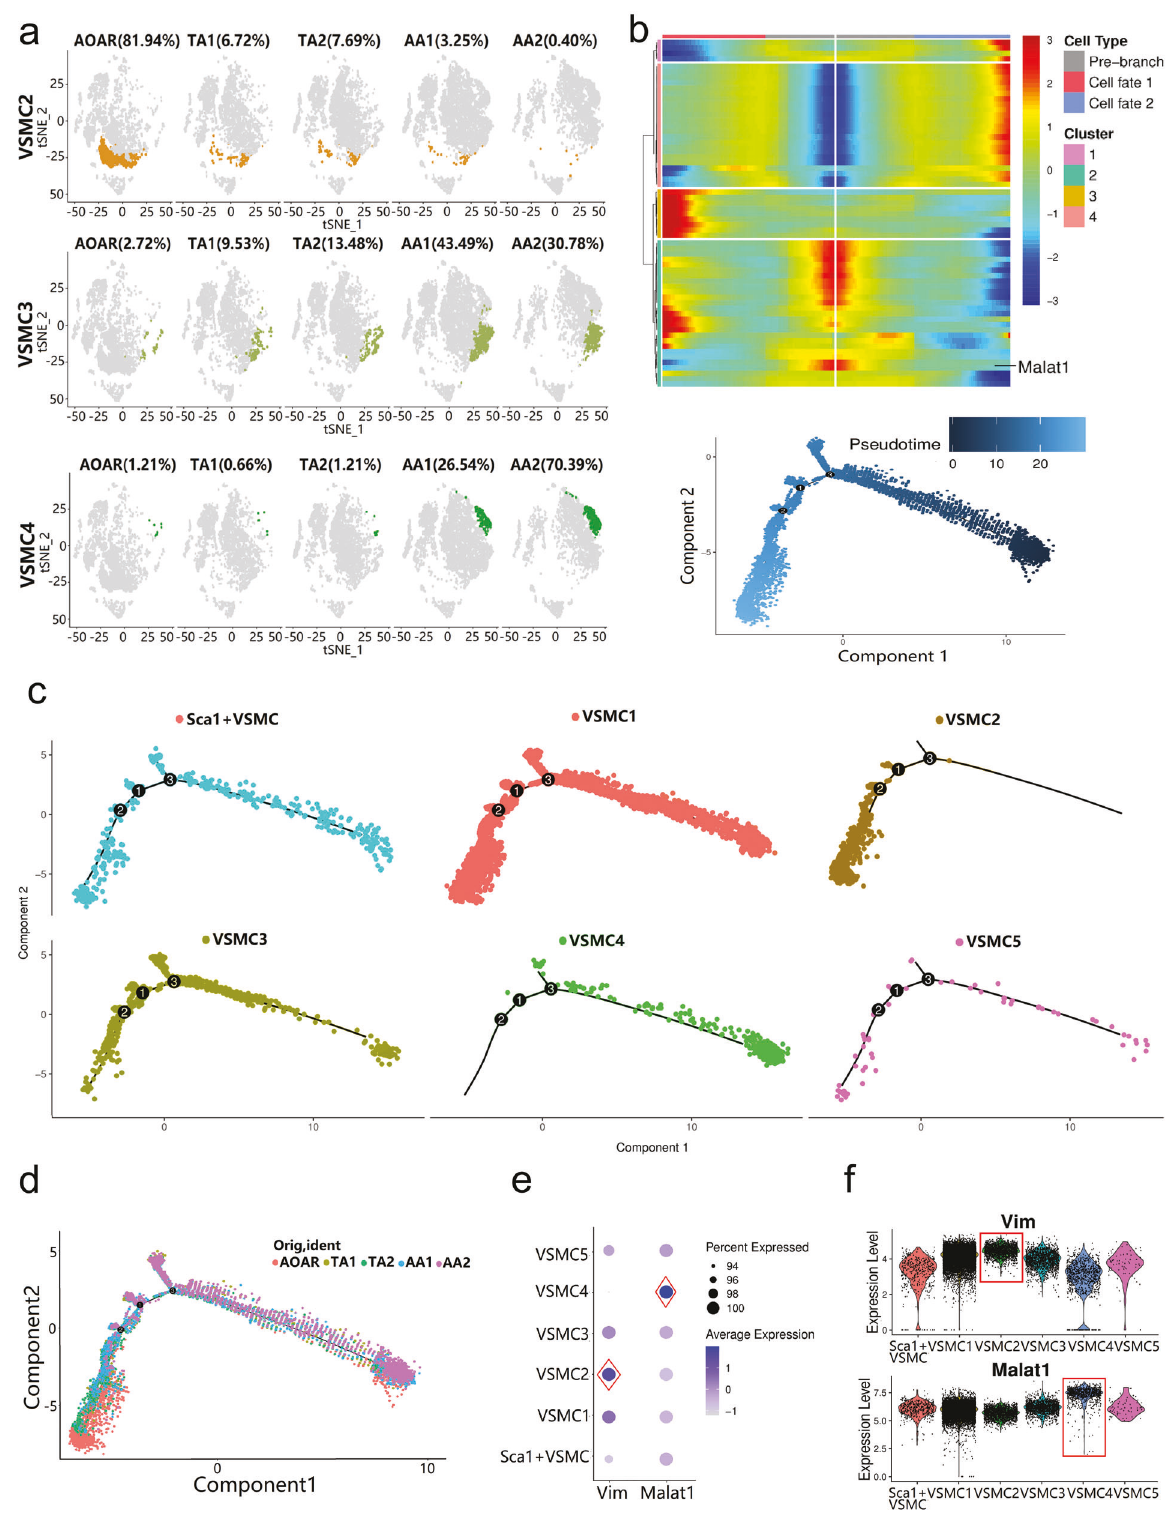
Fig. 4 New special VSMC subtypes with segment distribution differences revealed by gene characteristics and branching gene expression trajectory analysis. a The gradient of spatial distribution occurred among three particular VSMC subtypes, VSMC 2, 3, and 4, which was visualized by the t-SNE plot. b Branching gene expression trajectory analysis was performed based on dependent genes, including Malat1 . The pseudotime direction of cell differentiation is from right to left. c Different subpopulations appeared in diverse evolutionary directions. VSMC 2 and 4 developed into two opposite differentiation directions. d The fi ve segments resulted in the direction dominated by subtype differentiation, particularly the difference between thoracic and abdominal segments. The differentiation direction of AA was consistent with the VSMC 4. e The expression of genes Vim and Malat1 in VSMC 2 and 4 separately was relatively higher than that in the other subtypes. f Cells belonging to VSMC 2 and 4 converged on a high expression level of markers in the violin plots ( P < 0.05 by one-way ANOVA) Signal Transduction and Targeted Therapy (2022)